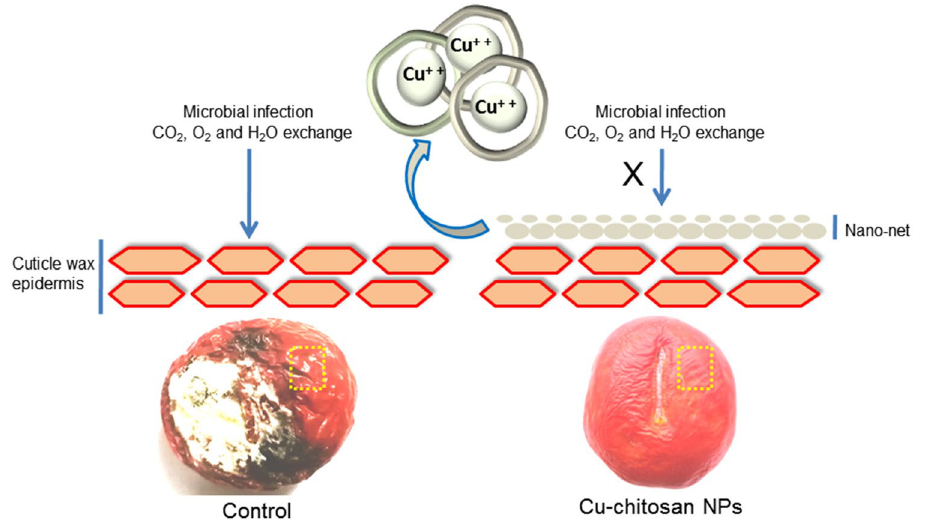
Figure 6. Hypothetical model of nano-net on tomatoes to extend the